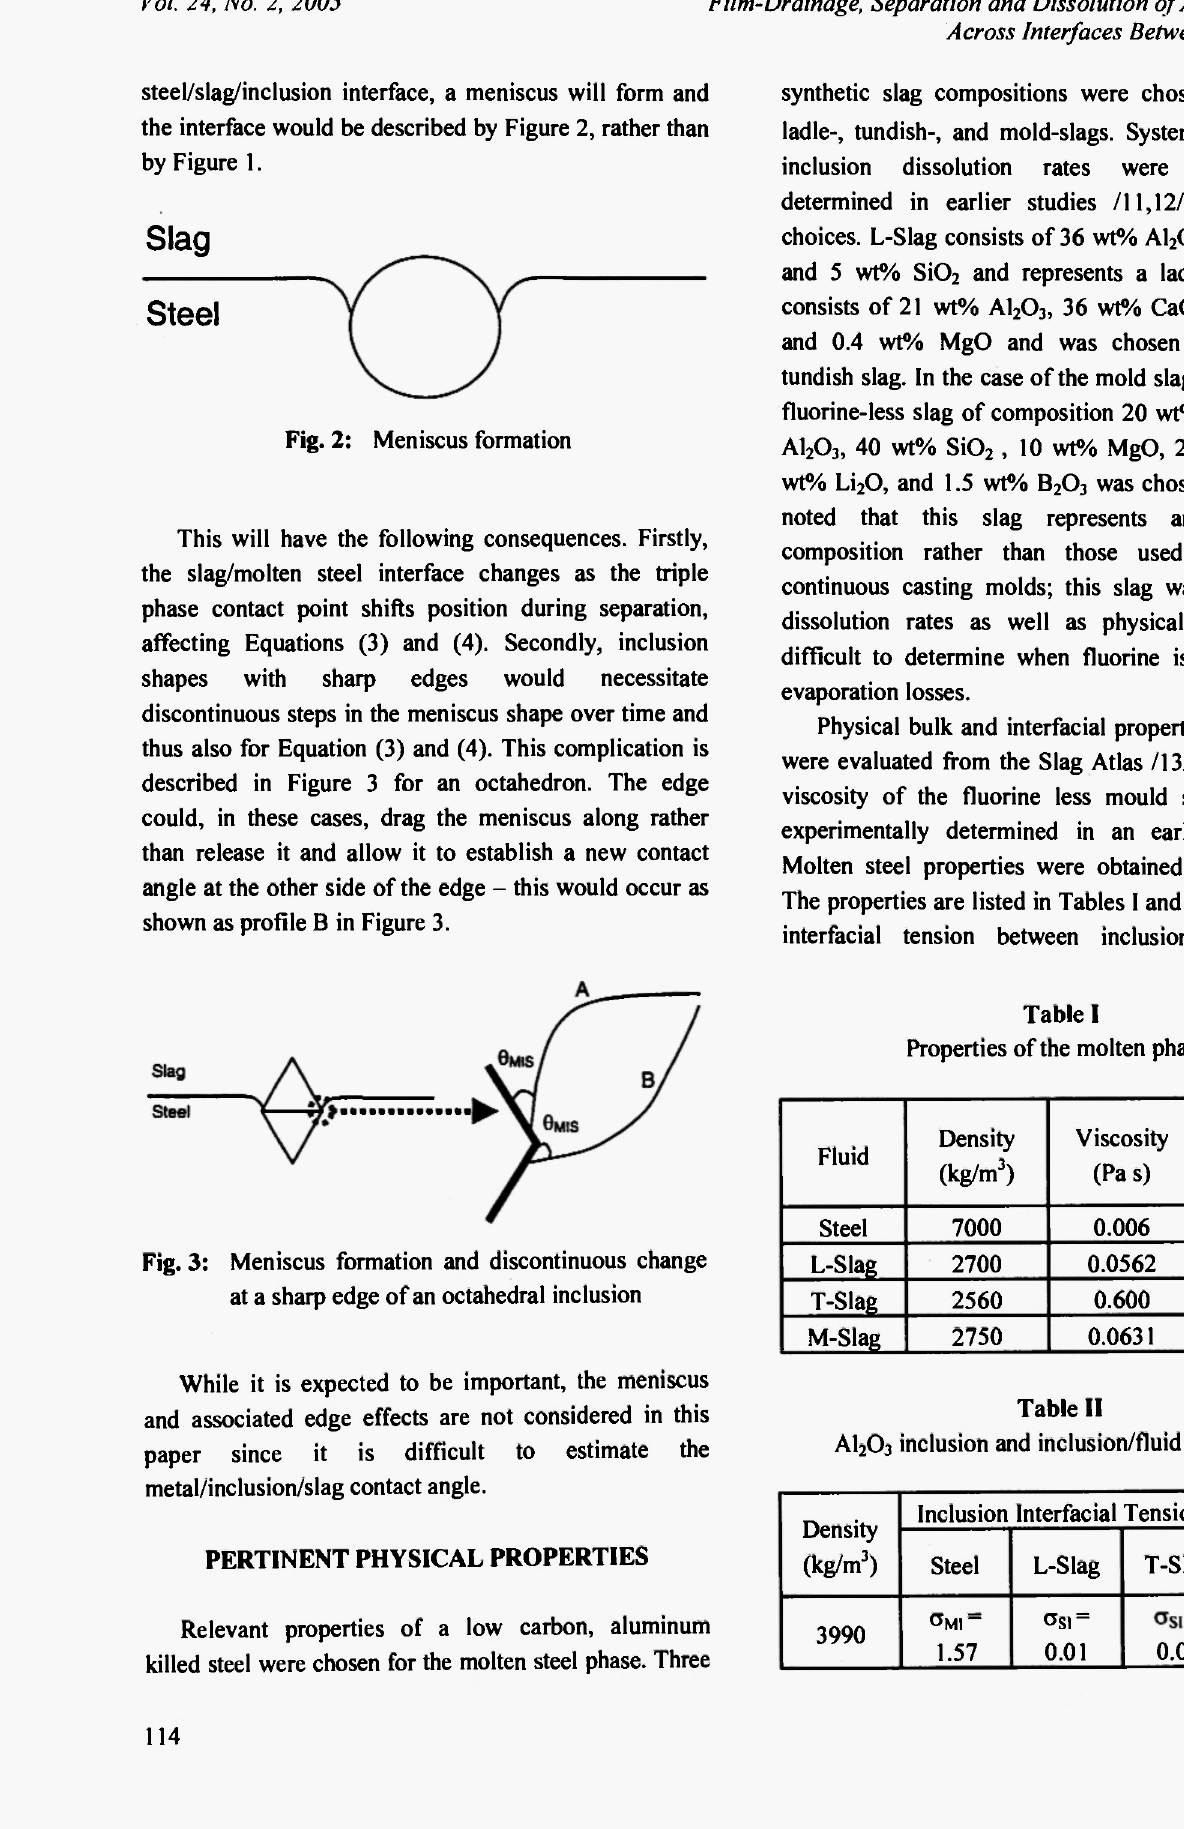
A1 2 0 3 inclusion and inclusion/fluid